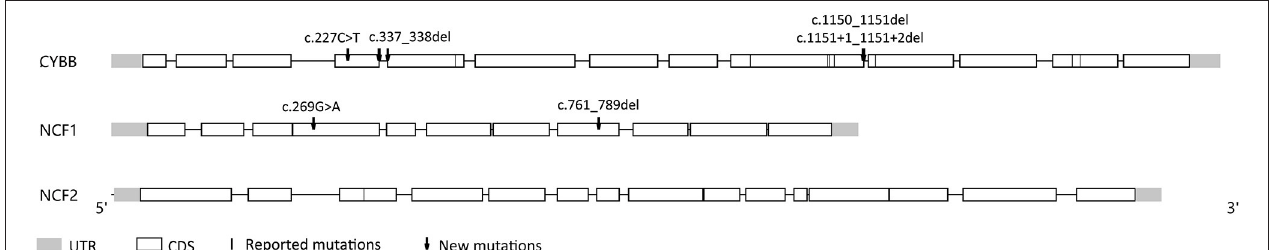
FIGURE 3 | A schematic diagram of the mutations in our